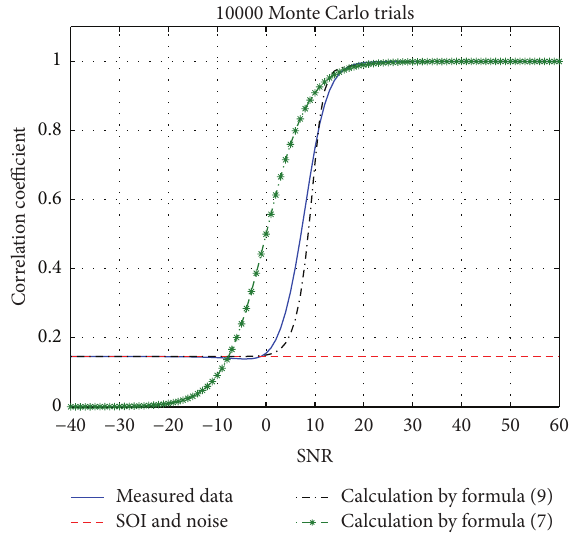
Figure 6: The relationship between correlation and